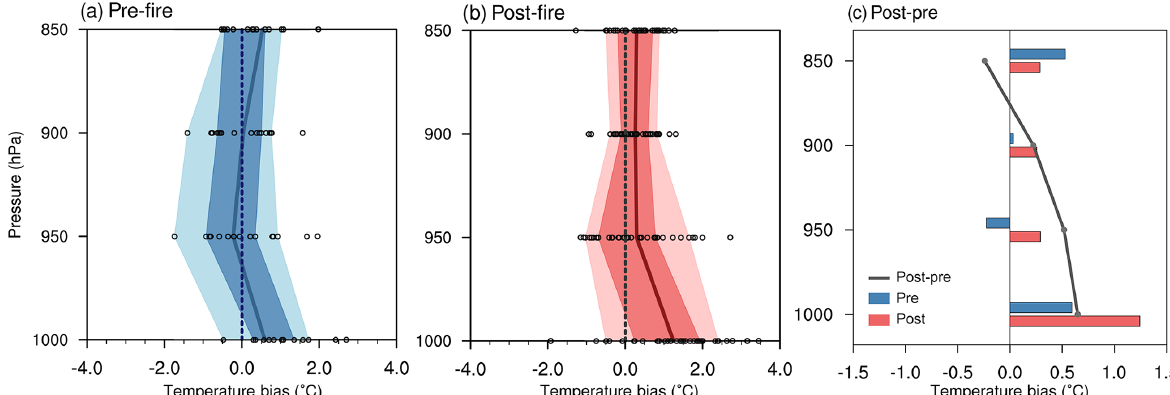
Figure 5. Temperature bias on isobaric levels between FNL analysis data and radiosonde observations (OBS) at 20:00LT at XZ (Xuzhou) on clear-sky days before and after BB in June 2007–2015: (a) pre-fire and (b) post-fire. Black circles mark the original value of temperature bias (OBS − FNL); the dash line marks zero; and the five curves of filled parts are the 10th, 25th, 75th, and 90th percentile and the average line in proper order. Bars in panel (c) are the mean value at separate levels, and the curve is the corresponding bias between “post-fire” and “pre-fire”. Note that the small black box in Fig. 4a marks the location of XZ (Xuzhou).